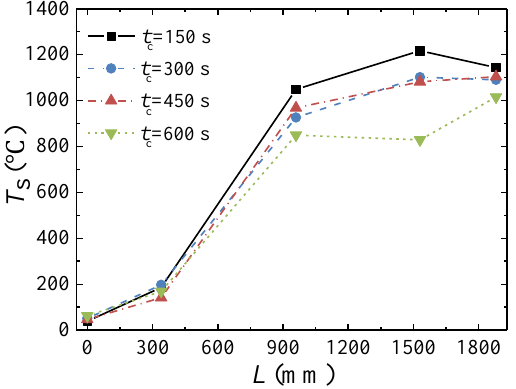
Figure 14. Solid temperature ( T s ) profiles of bed 1 along the length ( L ) of the TFRR for different cycle times ( t c ) at the end of the cycle when F in ≈ 105 × 10 3 Nm 3 /h and Y CH4,in = 0.95 vol %.